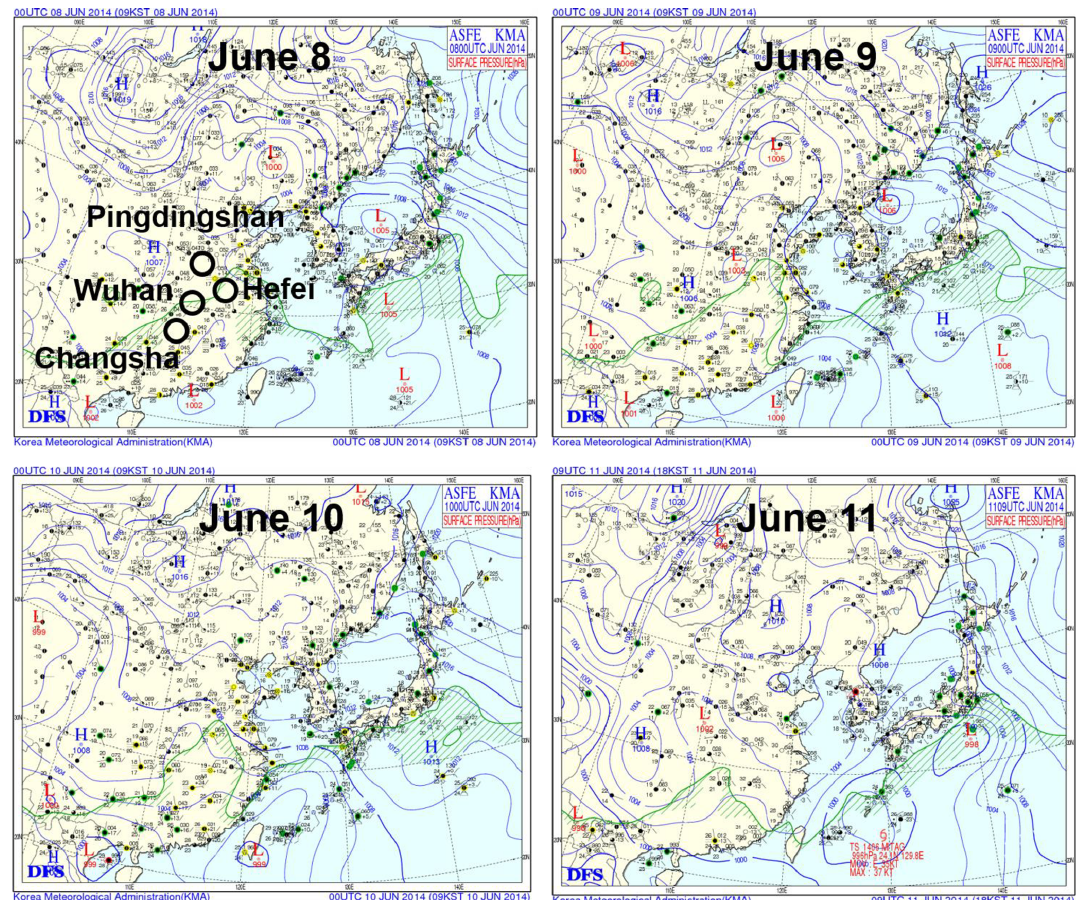
Figure 13. Surface weather maps for 8, 9, 10, and 11 June over CEC. Surface weather patterns were obtained from the Korea Meteorological Administration (http://www.kma.go.kr/eng/weather/images/analysischart.jsp, last access: 25 December 2019)